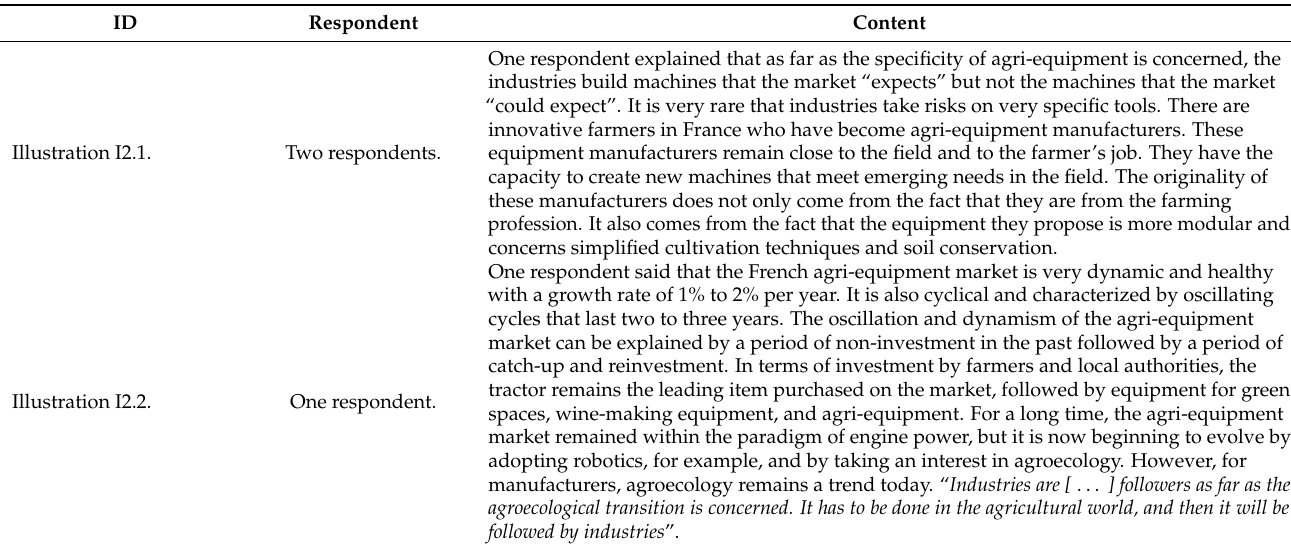
Table 7. Opinions concerning the agri-equipment